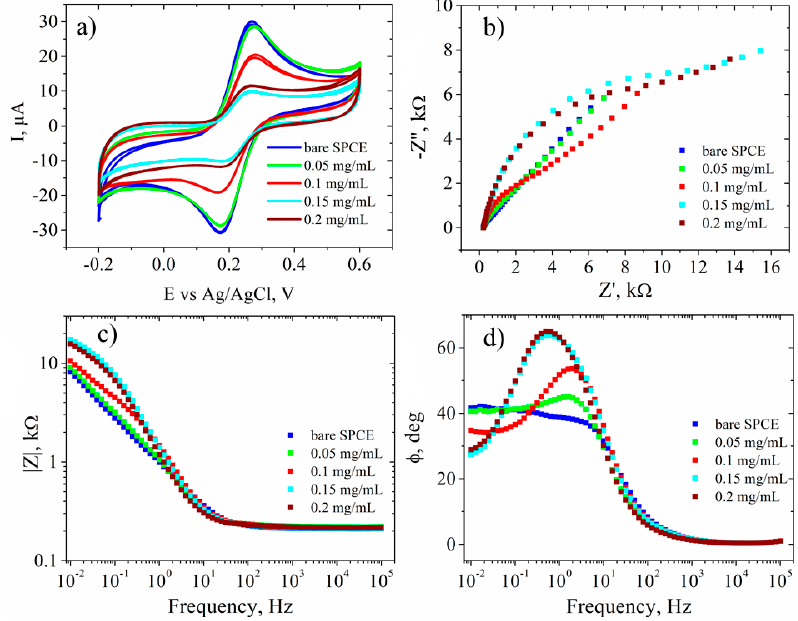
Figure 7. Electrochemical characterization: ( a ) CV; ( b ) EIS Nyquist plot; ( c ) EIS Bode plot—impedance modulus; ( d ) and phase shift. Characterizations were recorded in 1 mM [Fe(CN) 6 ] 3 − / 4 − , 0.1 M KCl, for bare SPCE (blue) and GO-SPCEs obtained using di ff erent concentrations of GO dispersions: 0.05 mg / mL (green), 0.1 mg / mL (red), 0.15 mg / mL (cyan), and 0.2 mg / mL (dark